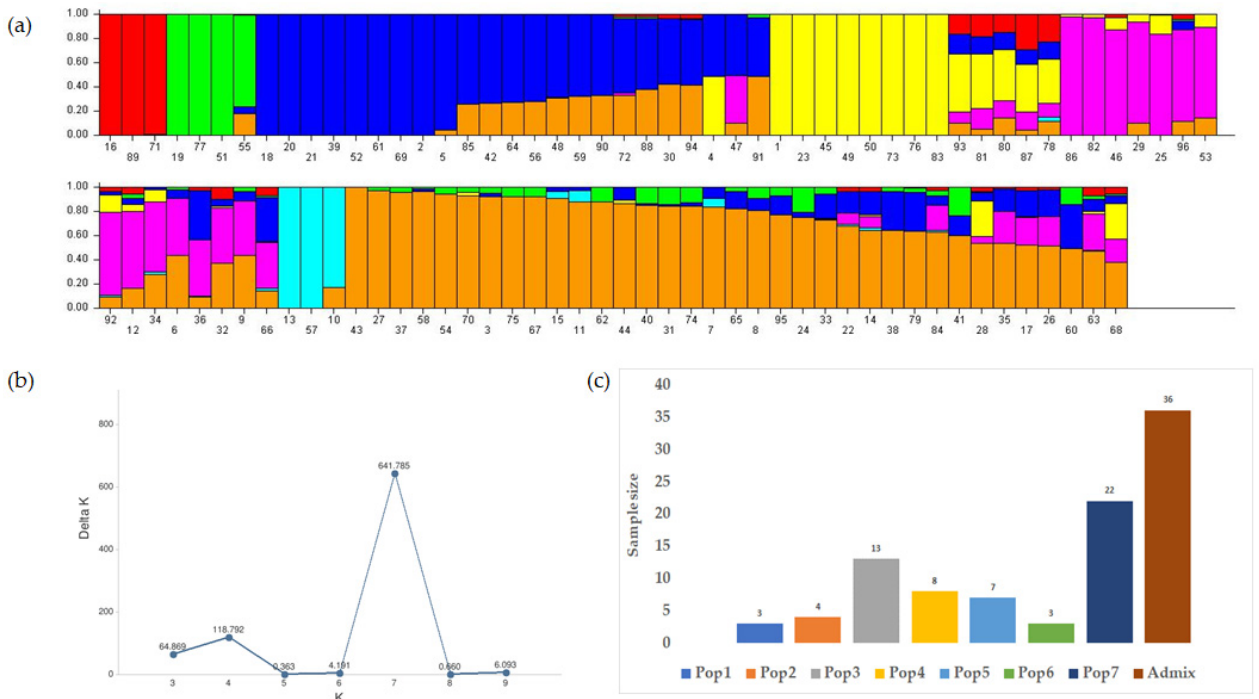
Figure 2. Population structure for 96 olive accessions from the USDA core collection using 54,075 SNP markers. ( a ) Sub- population grouping inferred by the STRUCTURE software indicated in seven different colors. The y-axis values indicate the probability of the population. ( b ) Evanno test for the ideal population number using LnP(D)-derived Δ K from 2 to 10. At a value of K = 7, it reaches its highest value, indicating the most probable subpopulations in the germplasm. ( c ) Olive accession number based on the populations identified by the STRUCTURE software.